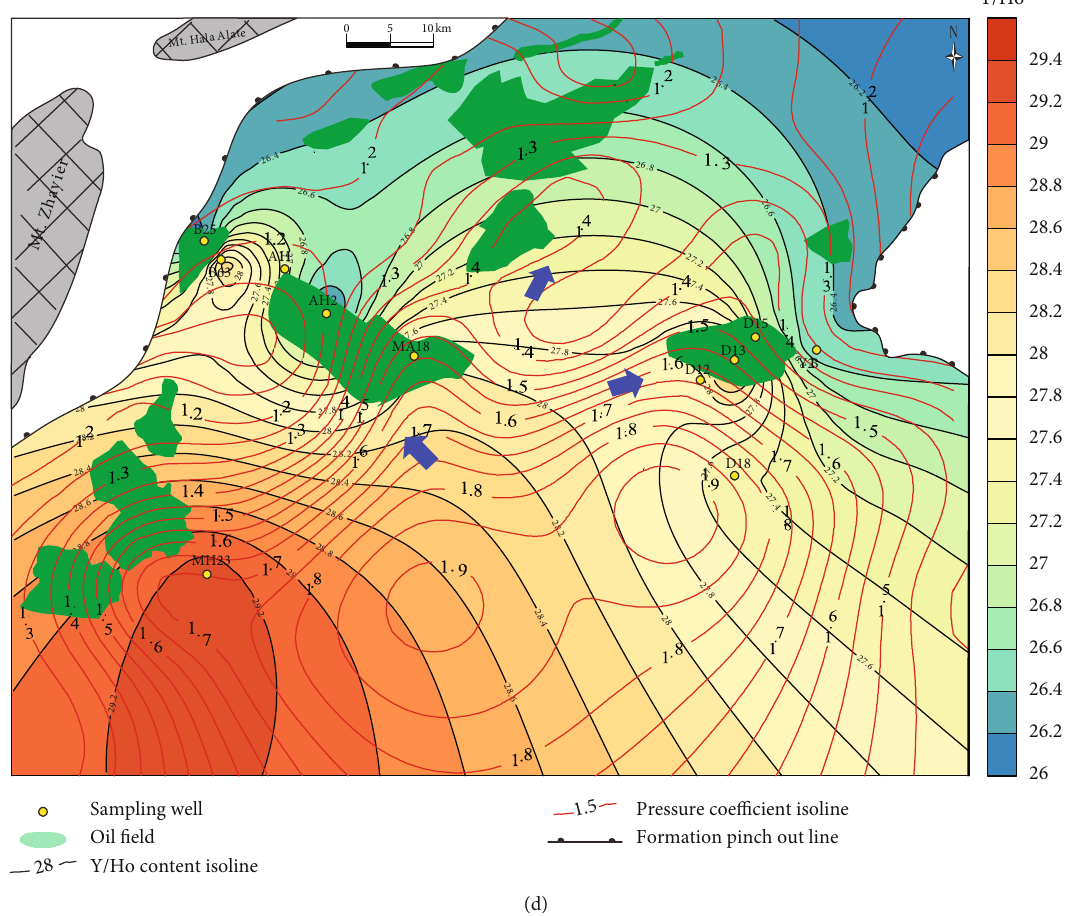
Figure 8: (a) Contour map of MnO contents (wt.%) and pressure coe ffi cients around the Mahu Sag. (b) Contour map of Sr contents (ppm) and pressure coe ffi cients around the Mahu Sag. (c) Contour map of MnO/Zr ratios and pressure coe ffi cients around the Mahu Sag. (d) Contour map of Y/Ho ratios and pressure coe ffi cients around the Mahu